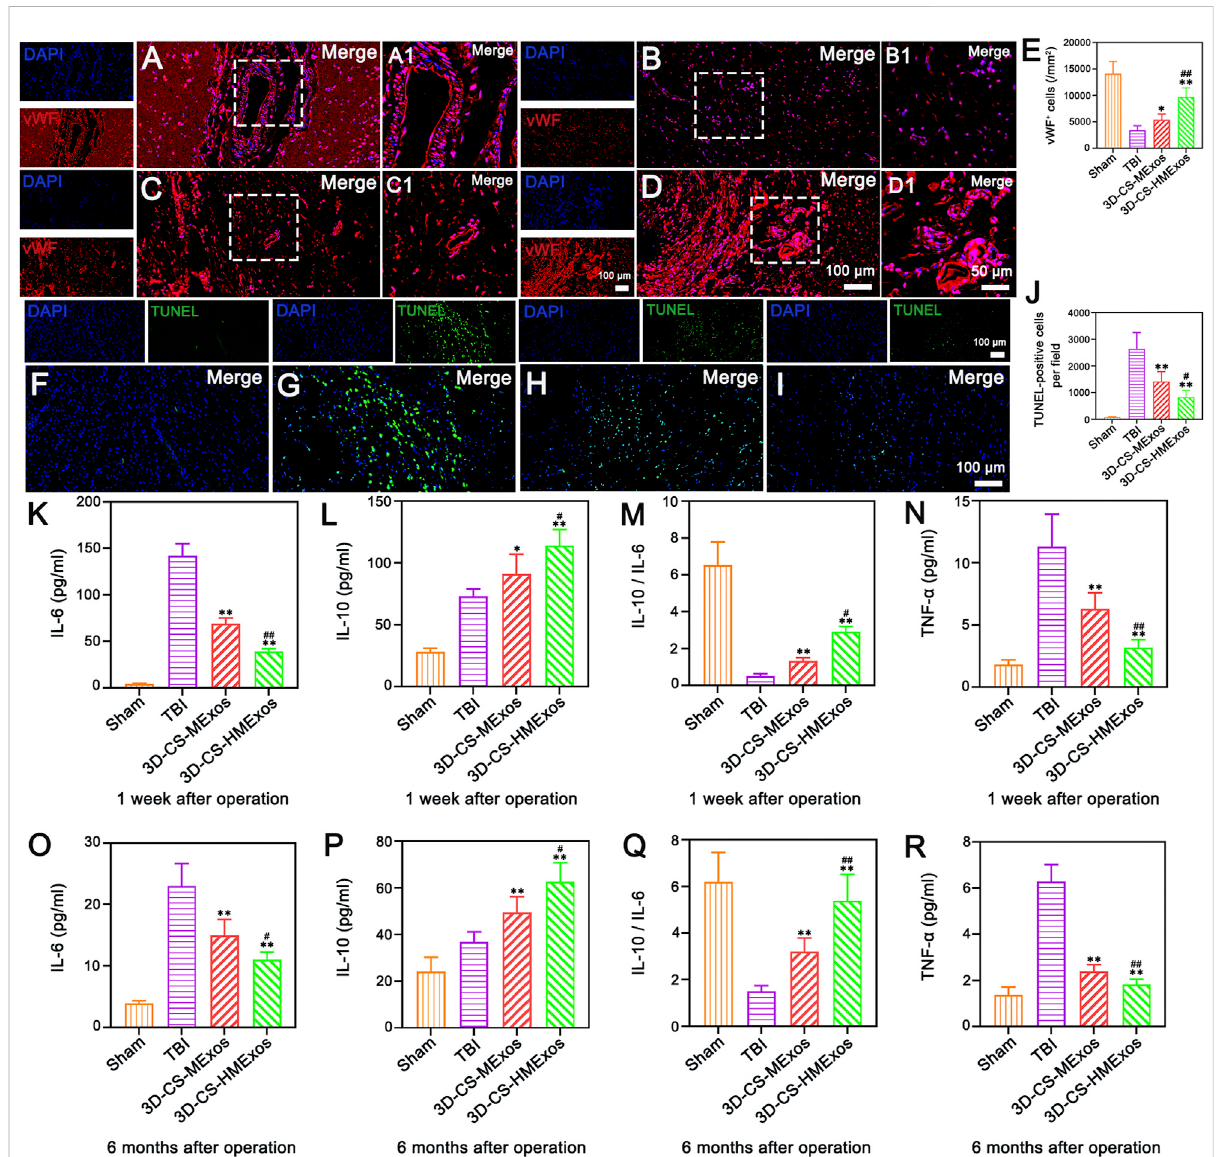
FIGURE 7 Hypoxia-induced exosomes combined with 3D-printed collagen and silk fi broin scaffolds signi fi cantly enhanced angiogenesis, inhibited apoptosis, and alleviated in fl ammation after TBI. (A – D) Representative image of vWF immuno fl uorescence staining (red) in the lesion area. (A – D) show the full view of the injured area, with the boxed adjacent and lesion areas magni fi ed in A1, B1, C1 and D1, respectively. Nuclei were stained with DAPI (blue). (E) Quantitative analysis of vWF-positive cells in the lesion area in the four groups. (F – I) Representative images revealing TUNEL- positive cells (green) indicative of cell apoptosis within the injured area at 6 months after TBI. Note that the 3D-CS-HMExos group showed fewer apoptoticcellsthantheTBIand3D-CS-MExosgroupsat6 monthsafterTBI. (J) QuantitativeanalysisofTUNEL-positivecells. (K – R) Graphsshowing the expression of the in fl ammatory factors IL-6 (K,O) , IL-10 (L,P) , IL-10/IL-6 (M,Q) , and TGF- α (N,R) in the acute (1 week) and chronic phases (6 months) after the operation. Note that lower levels of IL-6 and TGF- α and higher levels of IL-10 were observed in the 3D-CS-HMExos group than in the 3D-CS-MExos group at 1 week and 6 months after the operation. In general, 3D-CS-HMExos diminished proin fl ammatory cytokine (IL-6, TGF- α ) release but enhanced anti-in fl ammatory cytokine (IL-10) release after TBI. The image on the right is an enlarged image of the image in the white box of the image on the left. * p < 0.05, ** p < 0.01 vs. TBI group. # p < 0.05, ## p < 0.01 vs. 3D-CS-MExos group, n =